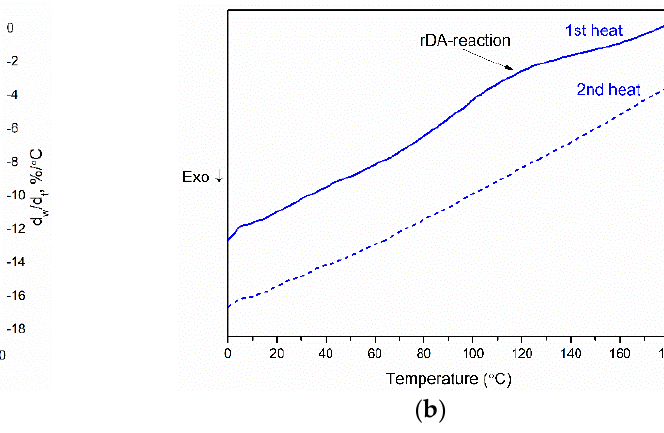
Figure 4. TGA and DTG ( a ) curves, DSC curves ( b ) of PU-DA.